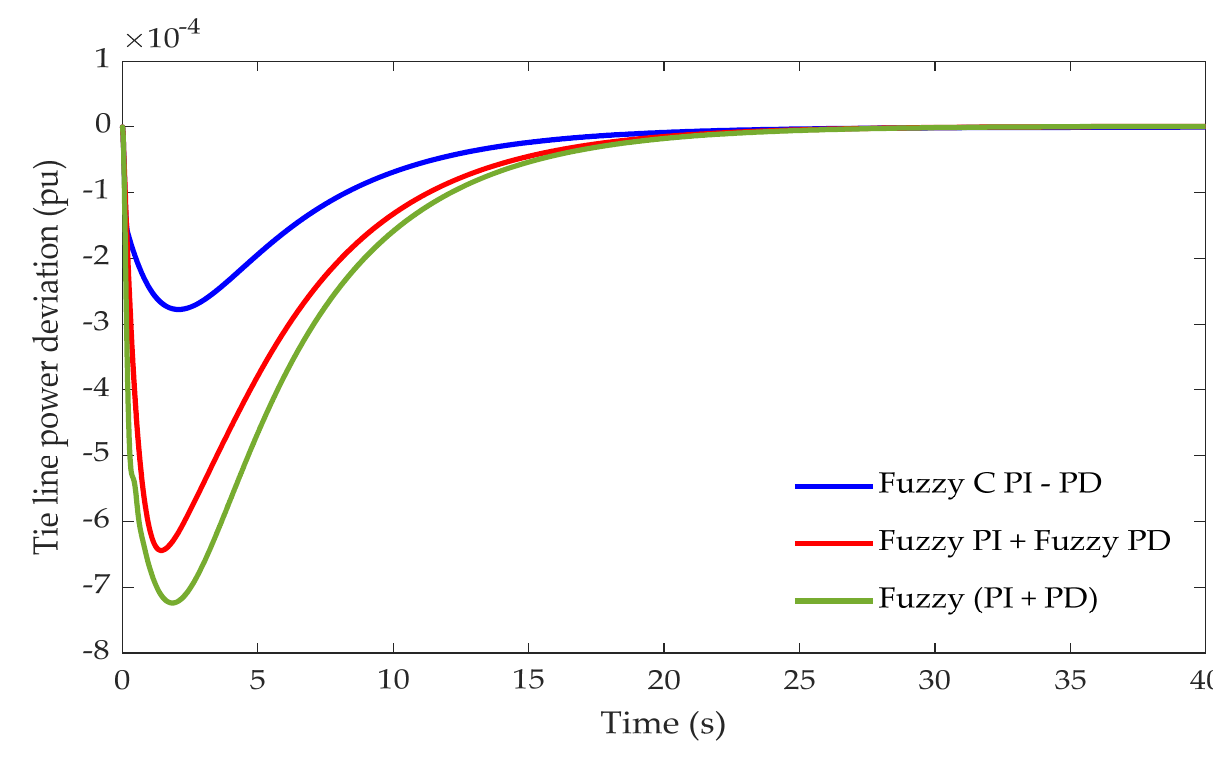
in pu). Figure 21. Tie-line power deviation ( ∆ P tie tie in pu).